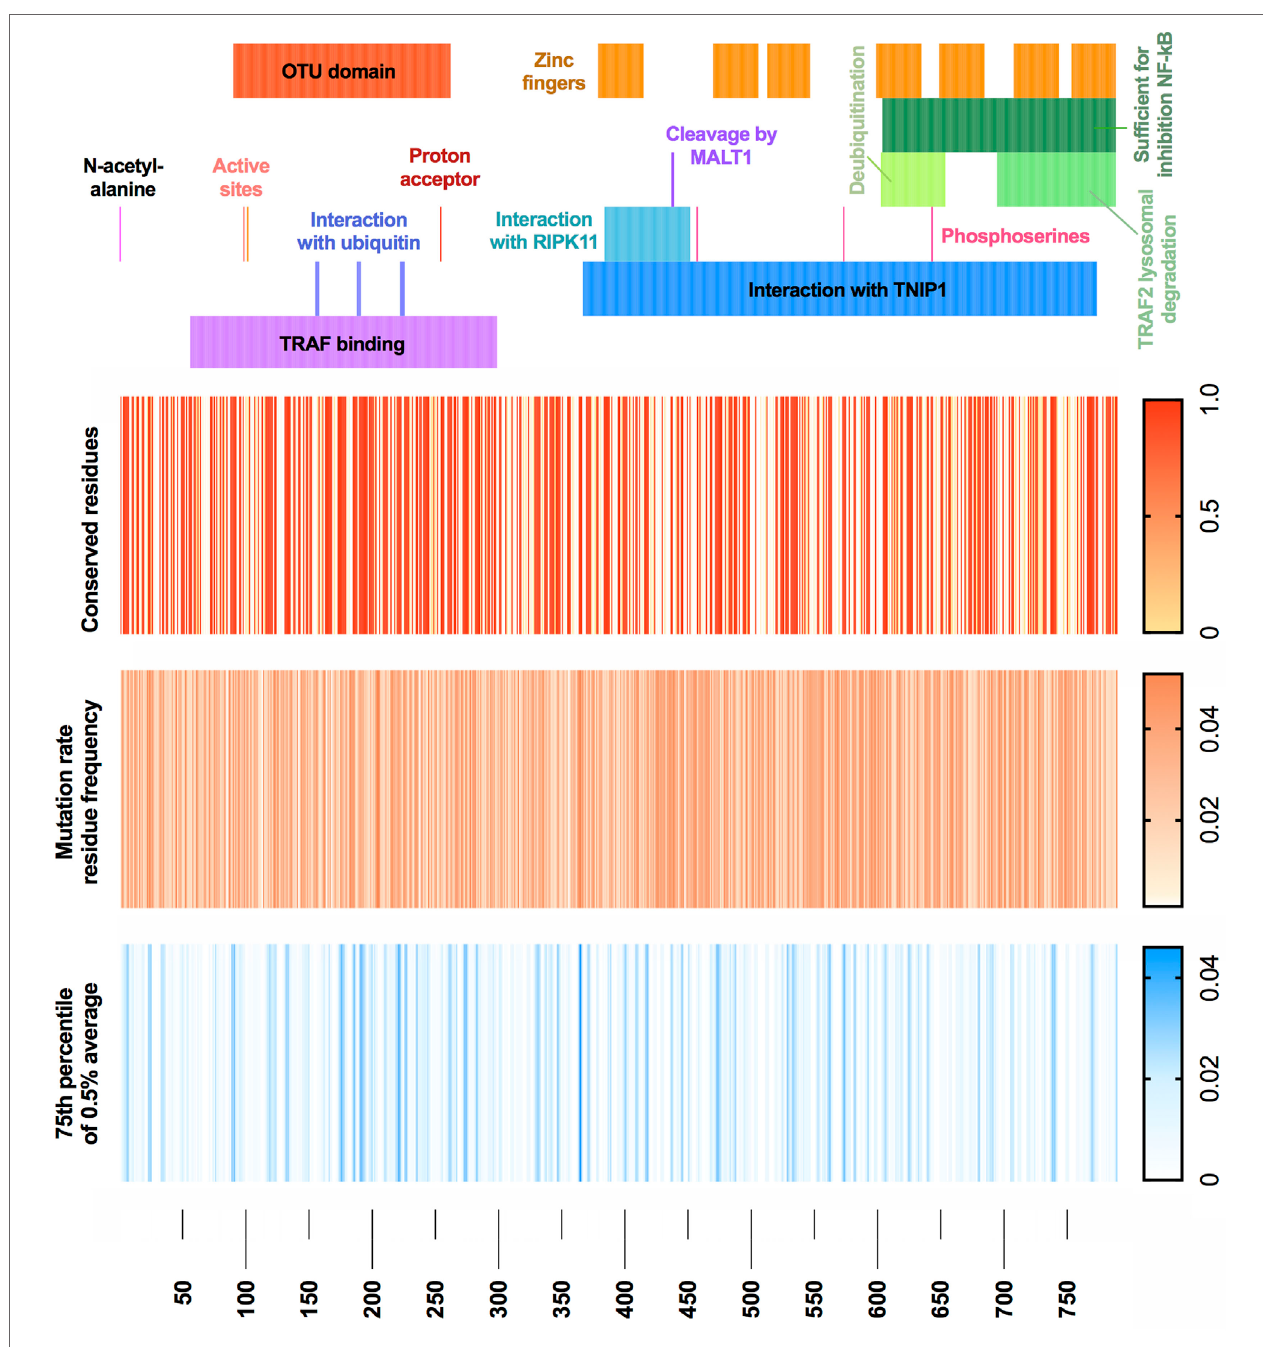
FIGURe 4 | A20 conservation and mutation rate residue frequency. (Top) Gene structure with functional domains. (Heatmap 1) Population genetics conservation rate, non-conserved 0 and conserved 1. (Heatmap 2) Raw MRF score prediction for conserved residues, graded 0 to 0.05. (Heatmap 3) MRF score averaged with 0.5% intervals for each respective gene and cutoff below 75th percentile, graded 0 to 0.045 (noise reduction method). Population genetics data used GnomAD (version r2.0.2); median number of alleles was 245,478 (SD 97,833) covering the TNFAIP3 canonical transcript ENST00000237289 (GRCh37 6:138188351— 138204449). Filtering retained variants with the identifiers: frameshift, inframe deletion, inframe insertion, missense, stop lost, or stop gained. Reference FASTA was sourced from Ensembl TNFAIP3-201 ENST00000237289.8